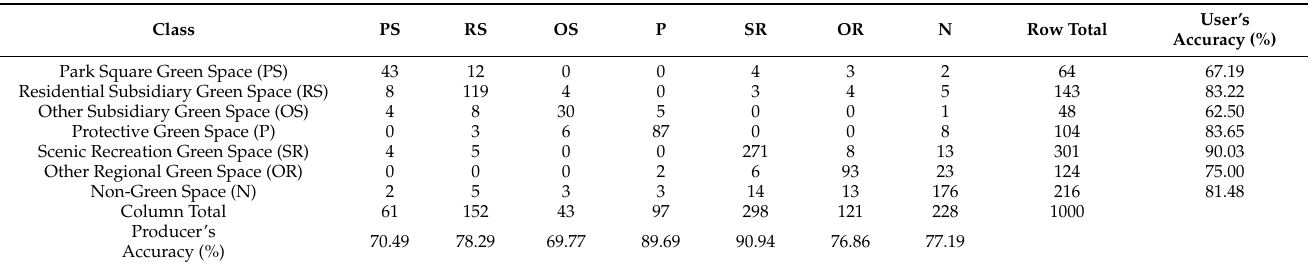
Table 5. Confusion matrix of functional types of